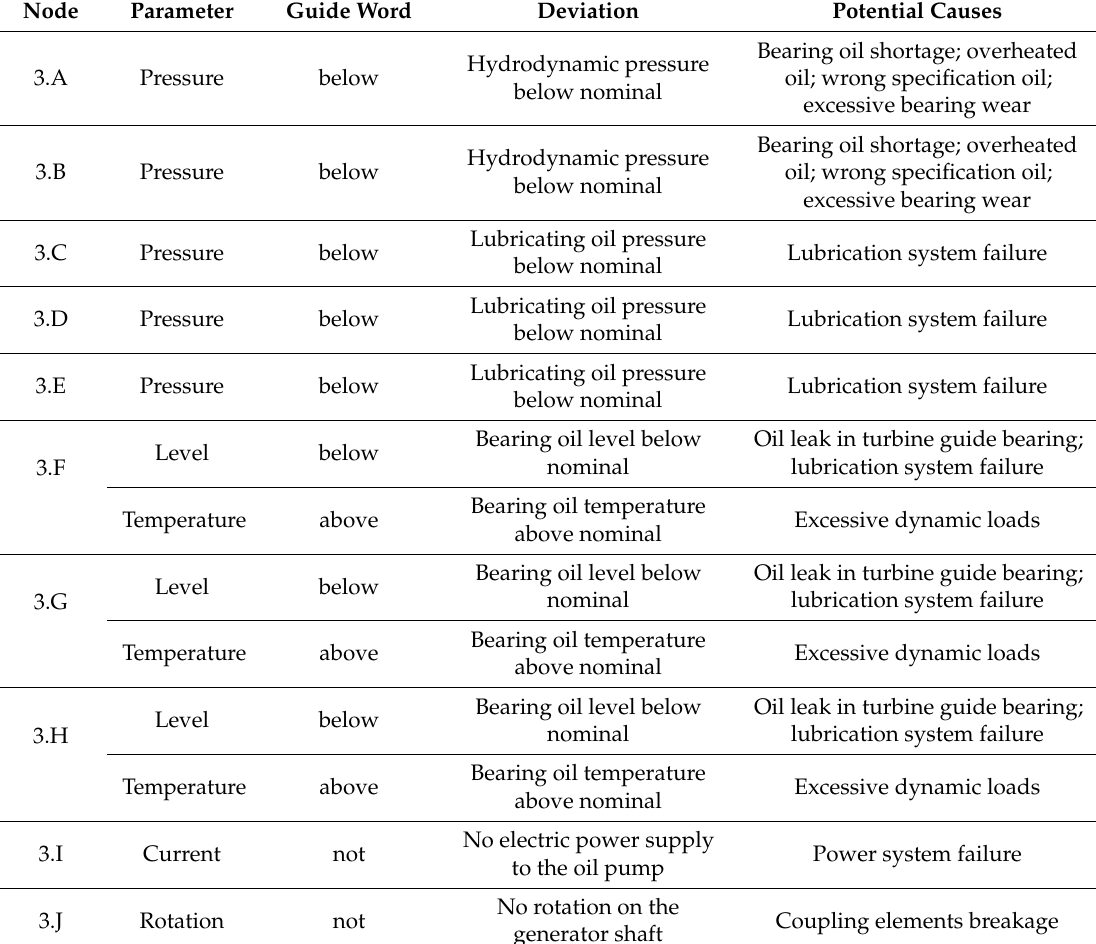
Table 8. Shaft Hazard and Operability Analysis (HAZOP)